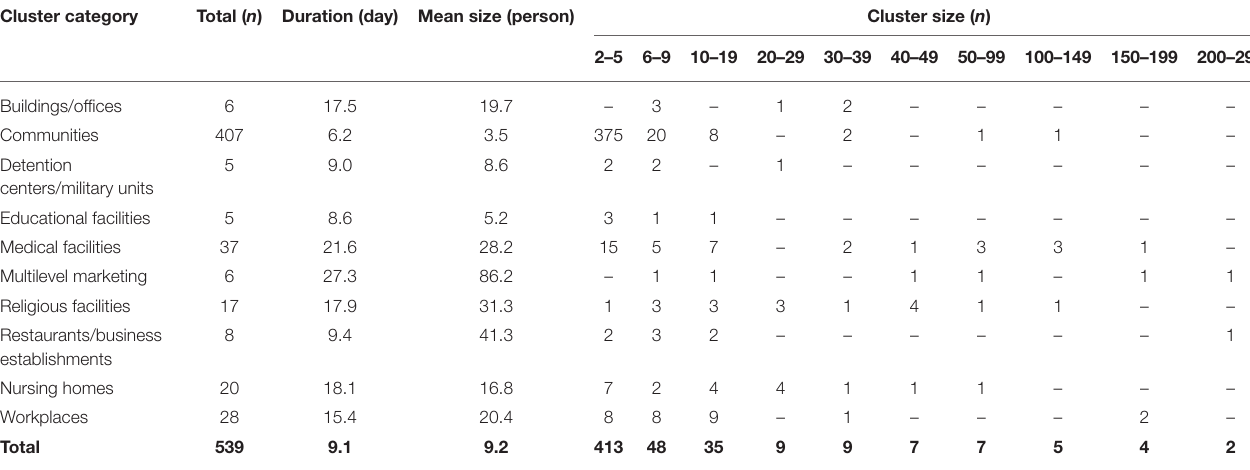
TABLE 1 | Overall description of COVID-19 clusters. Cluster